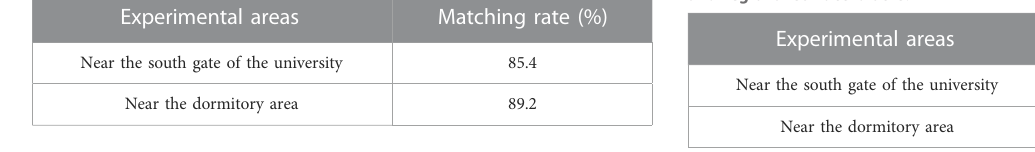
TABLE 12 Matching rate based on road segment matching process. TABLE 13 Matching rate based on the matching process between ground objects and regional surface